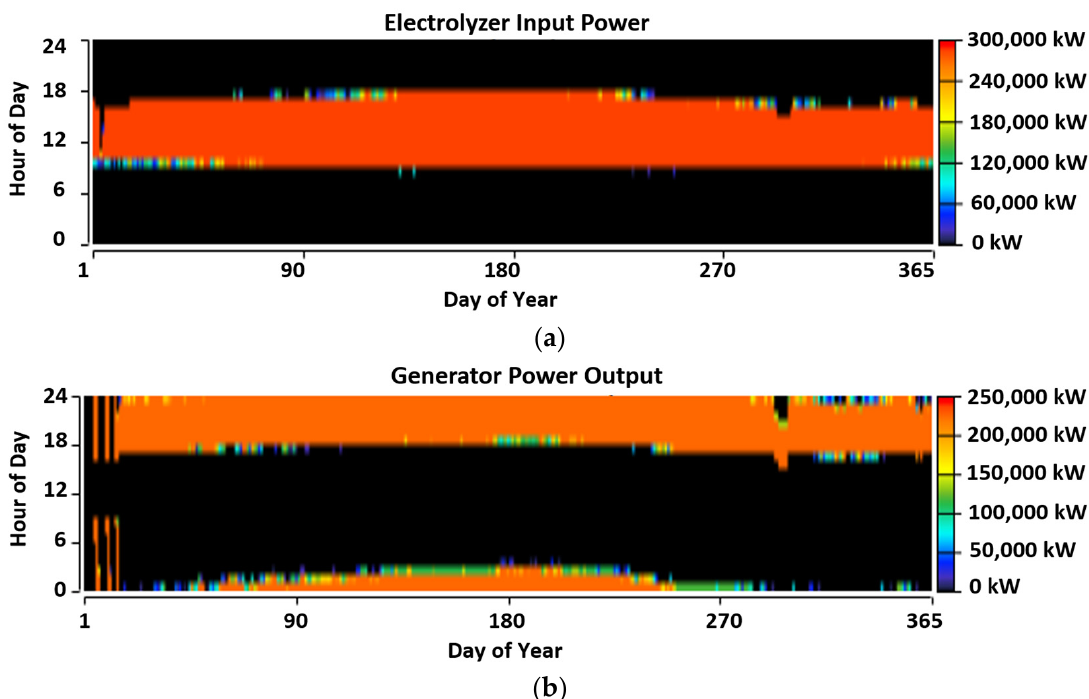
Figure 11. Yearly performance of the reverse pumping system. ( a ) Pumping; ( b ) turbination.